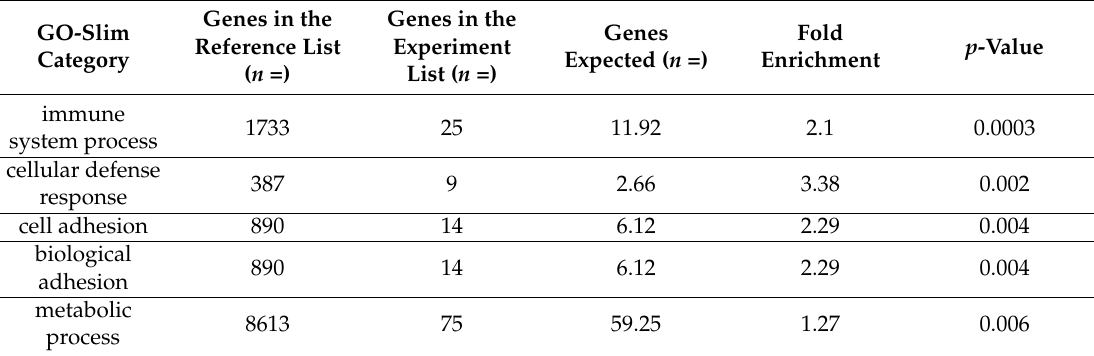
Table 2. Panther Go-slim Biological Processes which were overrepresented in sputum cells from asthmatics, at 4 h after a high fat meal compared with baseline.